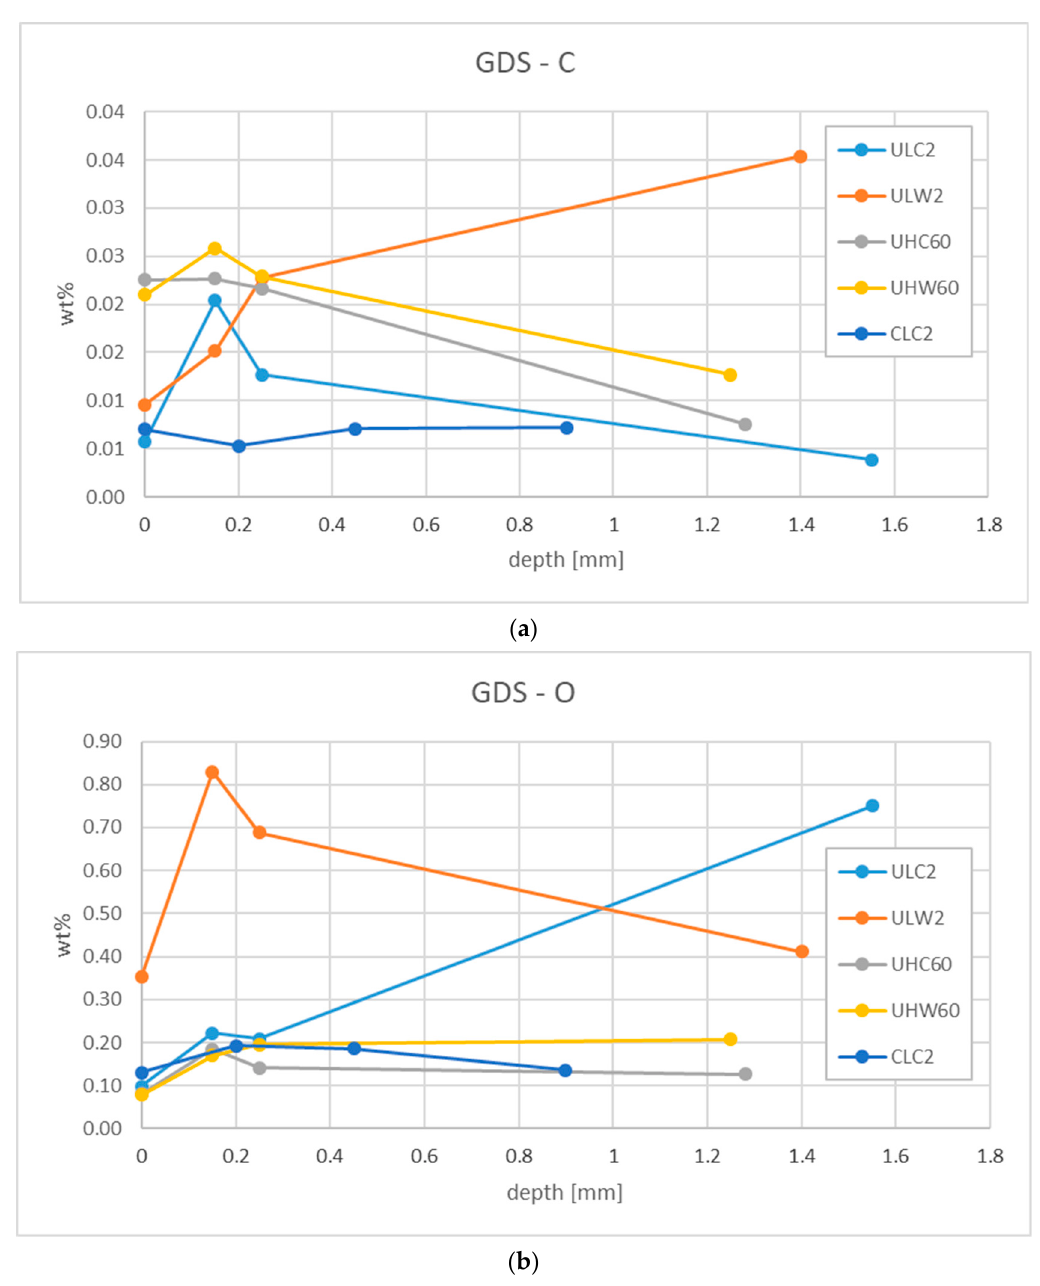
Figure 2. Through thickness carbon content ( a ) and oxygen content ( b ) in the ULW2, ULC2, UHW60, UHC60 and CLC2 samples, determined by GDS. Sample surface is on the left.